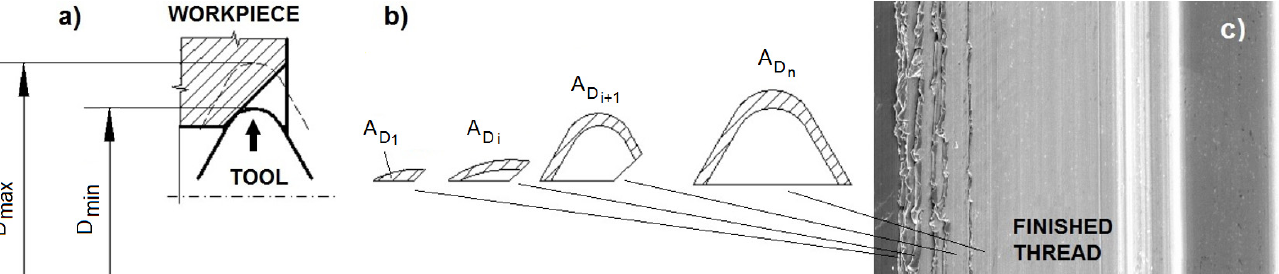
Figure 1. A scheme of individual steps when forming thread: ( a ) the position of the forming tool, ( b ) ascending cross-section of the area to be formed into the thread, ( c ) the surface of the produced thread with typical profile marks at the periphery of the surface.